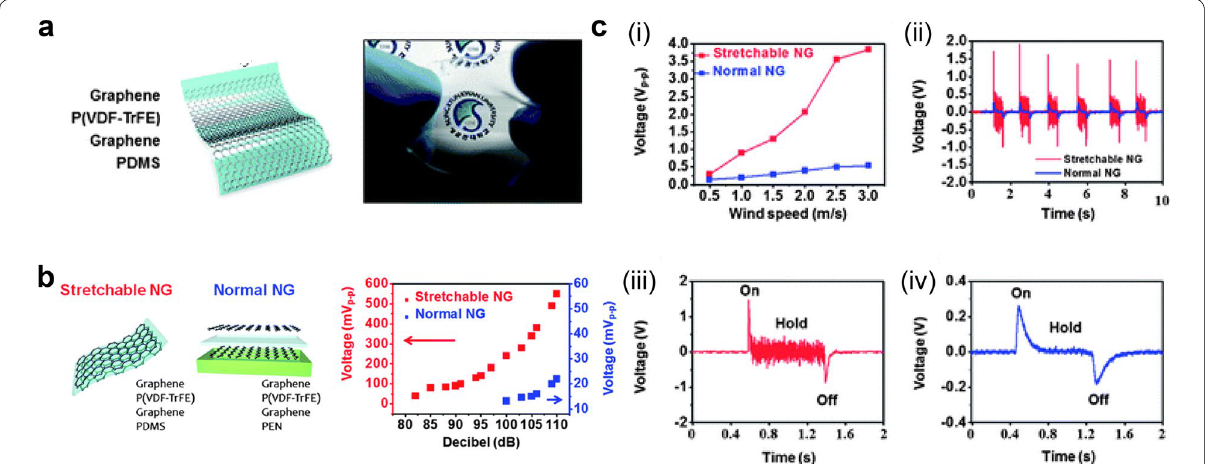
Fig. 4 a Schematic structure and real image of polymeric ferroelectric material based PENG. b Output voltage measurement with applied sound wave, and c wind (Reproduced from [32] with copyright permission from 2013 Royal Society of